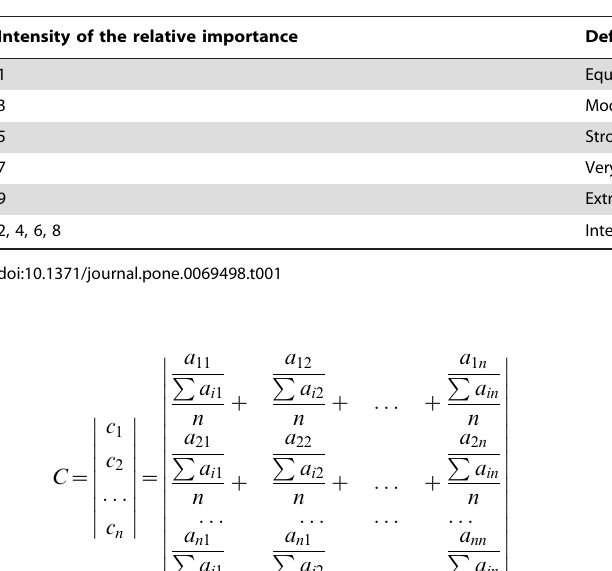
Intensity of the relative